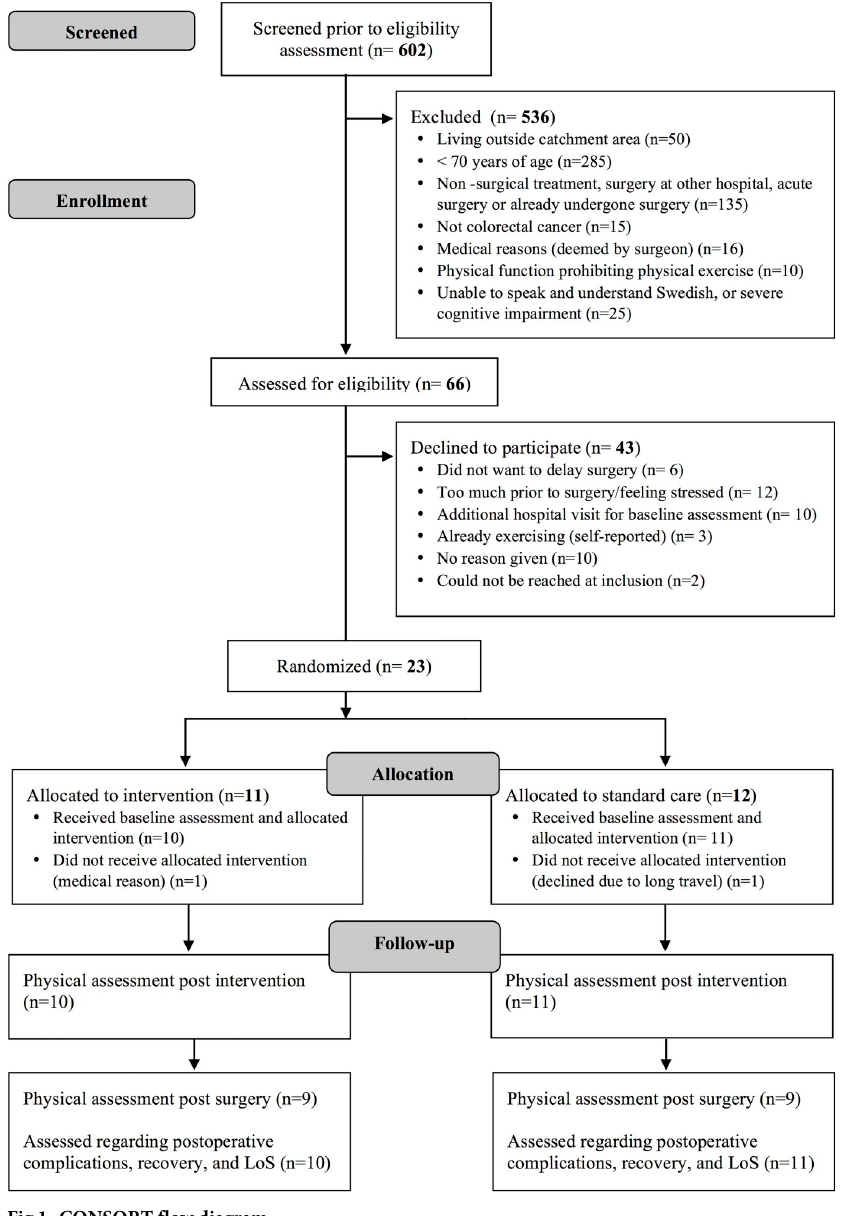
Fig 1. CONSORT flow